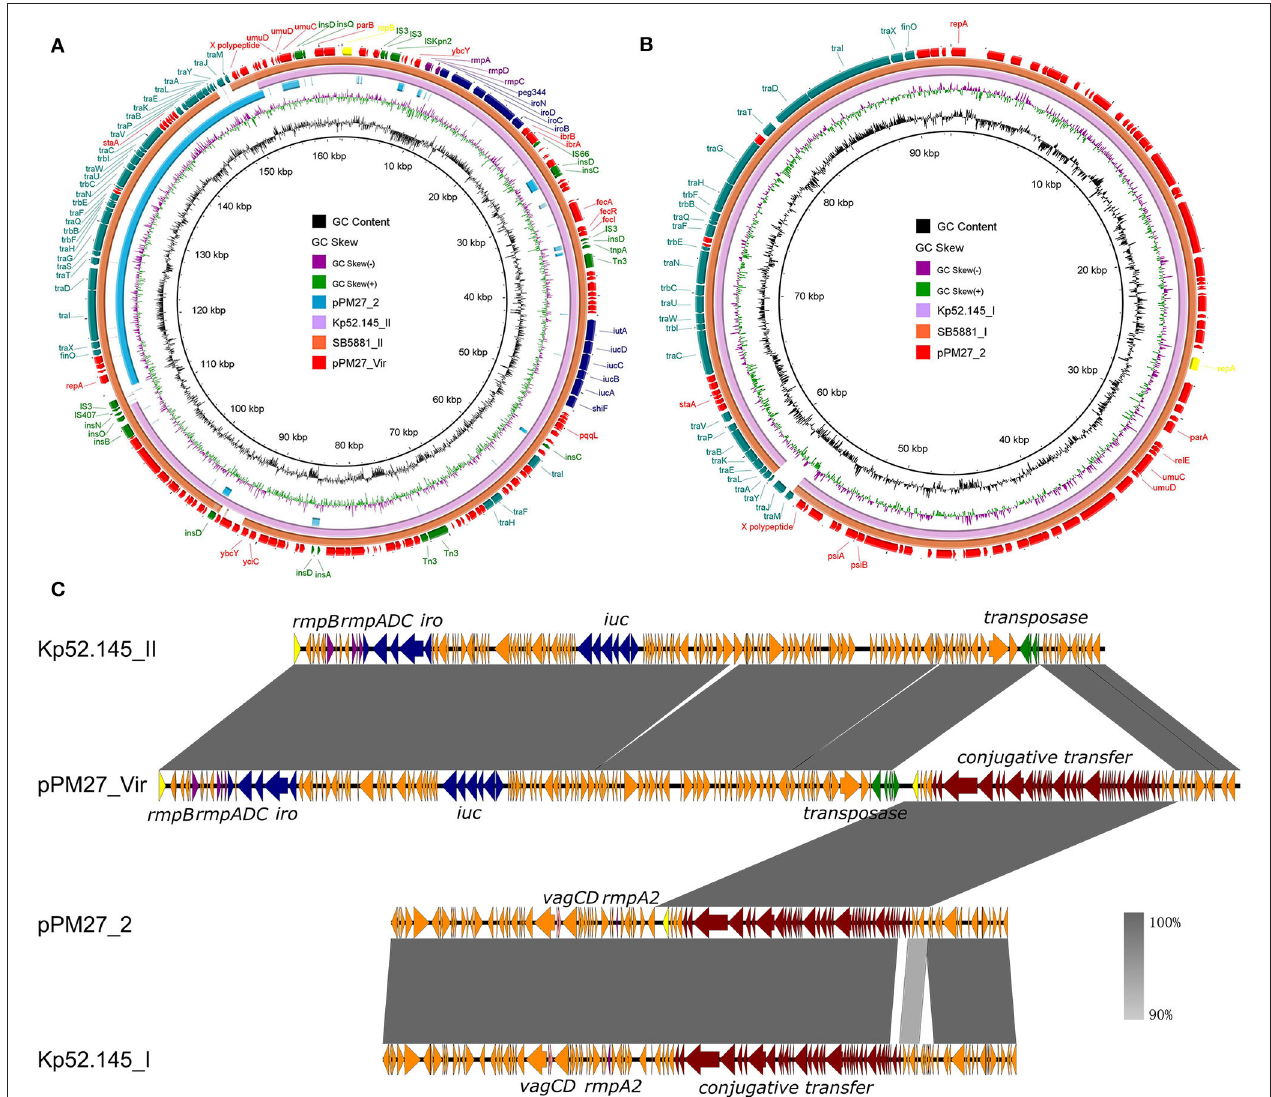
FIGURE 2 | Alignment of plasmids pPM27_Vir and pPM27_2 with similar plasmids. (A) Alignment of plasmid pPM27_Vir with similar plasmids by BRIG. Plasmid pPM27_Vir showed the highest similarity to SB5881 plasmid II (GenBank accession no. LR792629.1, 97% coverage and 99.89% identity) and Kp52.145 plasmid II (GenBank accession no. FO834905.1, 73% coverage and 99.97% identity). (B) Alignment of plasmid pPM27_2 with similar plasmids by BRIG. Plasmid pPM27_2 showed the highest similarity (98% coverage and 99.9% identity) to both plasmids, namely, Kp52.145 plasmid I (GenBank accession no. FO384904.1) and SB5881 plasmid I (GenBank accession no. LR792630.1). (C) Alignment of plasmids pPM27_Vir and pPM27_2 with Kp52.145 plasmids by Easyfig. Plasmid pPM27_Vir could have been originated from Kp52.145 plasmid II by fusion with the IncF plasmid conjugative transfer genes from plasmid pPM27_2.